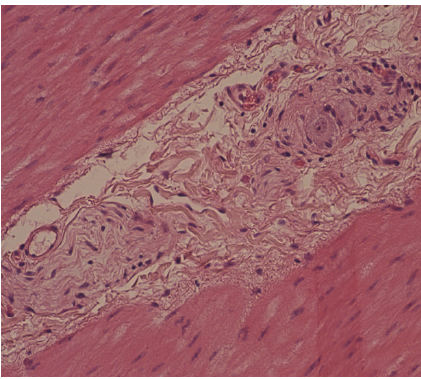
Figure 1: Intermesenteric plexus of a normal stomach. Normal nerve and a ganglion cell. (Haematoxylin-Eosin, × 200).